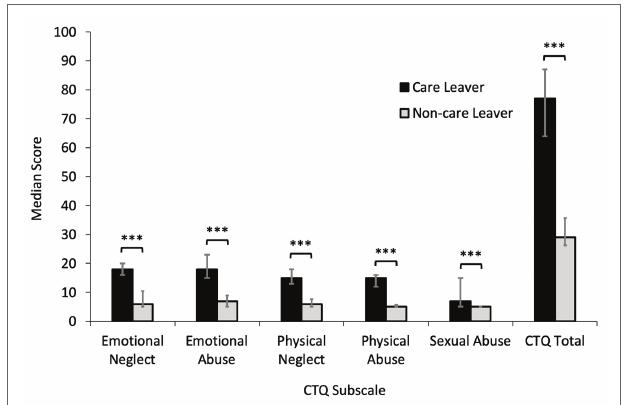
FIGURE 1 | Median Childhood Touch Questionnaire (CTQ) subscale scores for care leavers and non-care leavers with error bars showing 25th and 75th percentiles. Care leavers reported significantly higher levels of all types of childhood trauma (*** ps < 0.001), with total childhood trauma scores also significantly higher ( p <